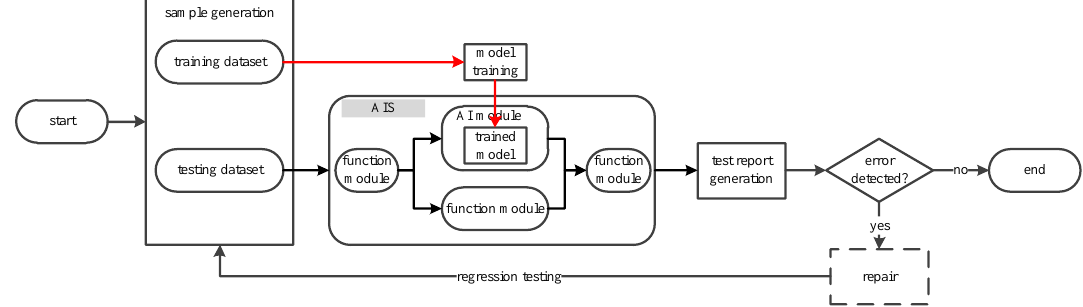
Figure 2. Workflow of the AI-in-the-loop system testing.